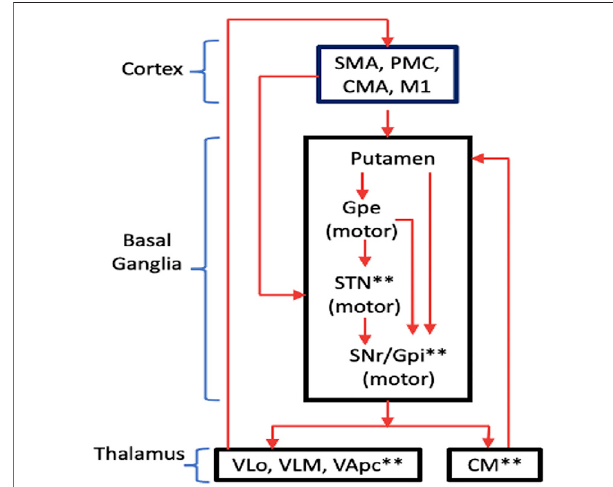
FIGURE 1 | Motor circuit of the CBGTC showing the segregated sub- circuits. The targets of current DBS treatments are labeled with asterisks (*). Abbreviations: SMA, supplementary motor area; PMC, premotor cortex; CMA, cingulate motor area; M1, primary motor cortex; Gpe, globus pallidus externa; SNr, substantia nigra pars reticulata; Gpi, globus pallidus internus VLo, ventrolateral nucleus of thalamus, pars oralis; VLm, ventrolateral nucleus of thalamus, pars medialis; VApc, ventral anterior nucleus of thalamus, pars parvocellularis. (redrawn from Wichmann and Delong., 2011).